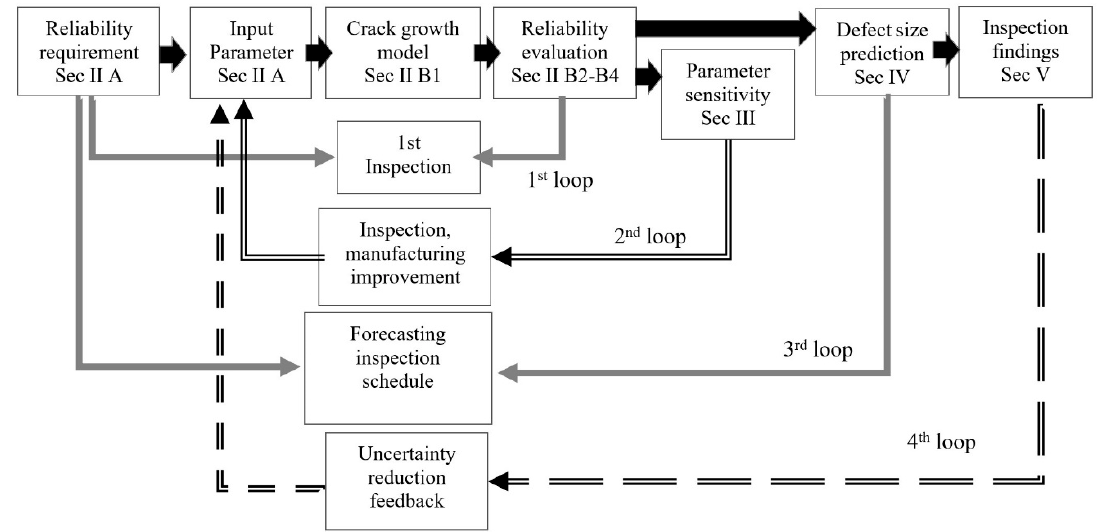
Figure 2. Schematic of proposed process for component-inspection definition. 92 Figure 2. Proposed steps in the additive manufacturing (AM)-component reliability-evaluation